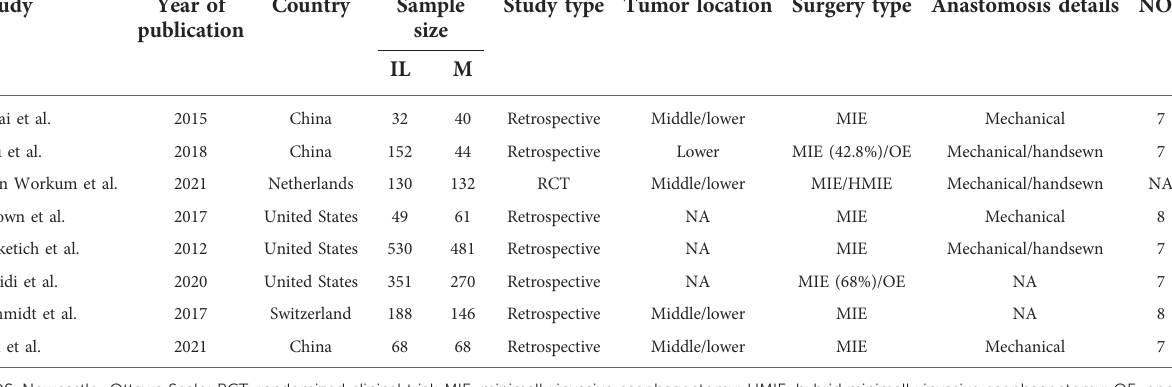
TABLE 1 Characteristics of included studies. Study Country Sample